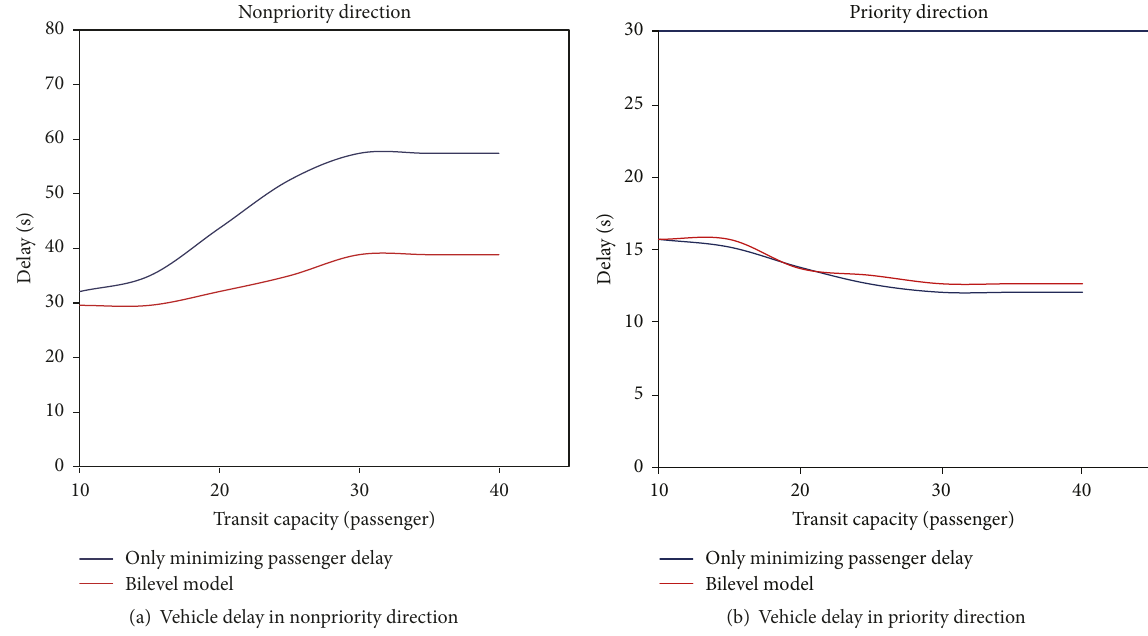
Figure 2: Vehicle delays of two directions with different transit